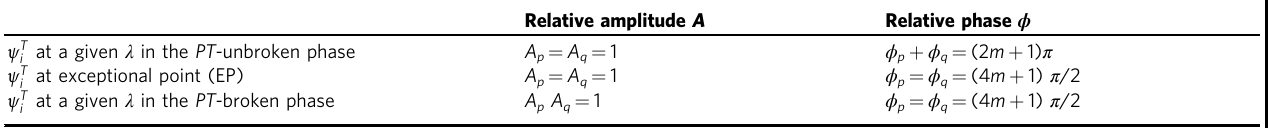
Table 1 Characteristics of eigenstates of a 4 × 4 S PT in different